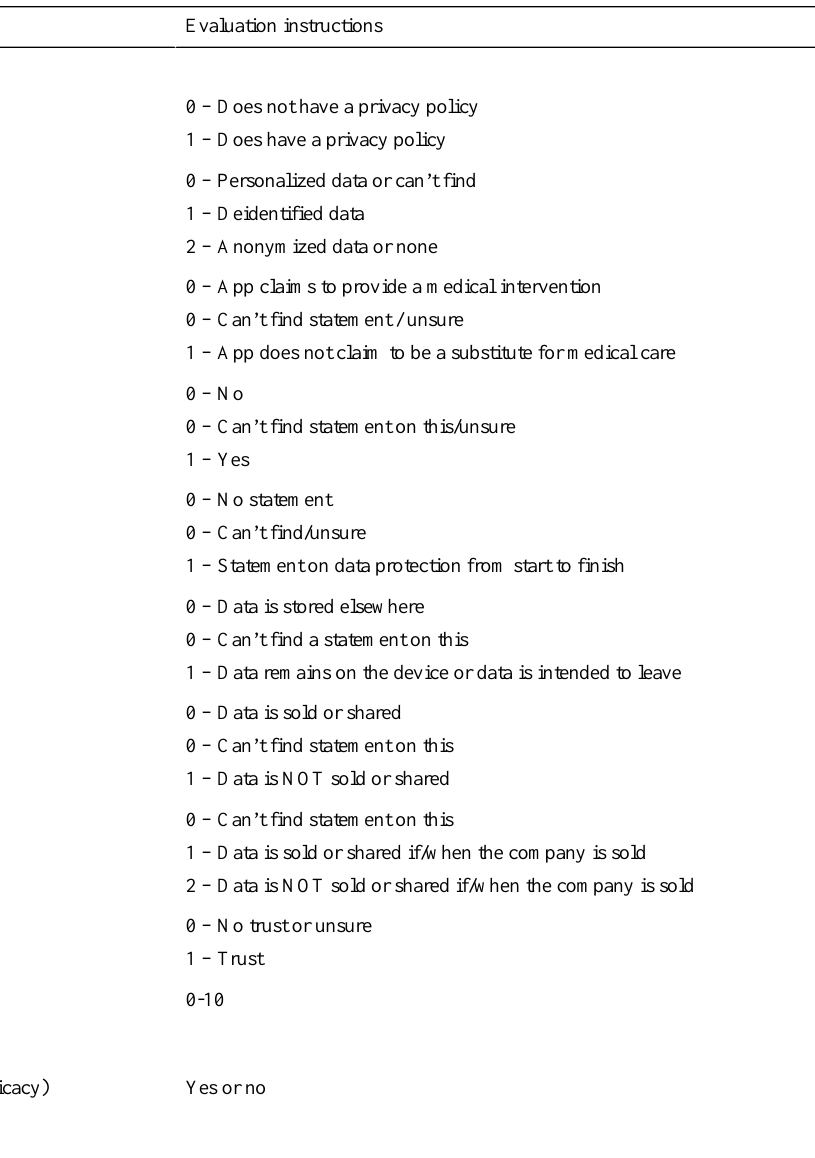
Table 1. App evaluation categories and questions. Privacy is evaluated by assessing each app’s privacy policy. Medical evidence is assessed through a quick internet search. The Price, Ratings, and Attributes categories can be answered with information collected in the App Store. Lastly, the Features, Onboarding, and Performance categories are evaluated by downloading and interacting with the